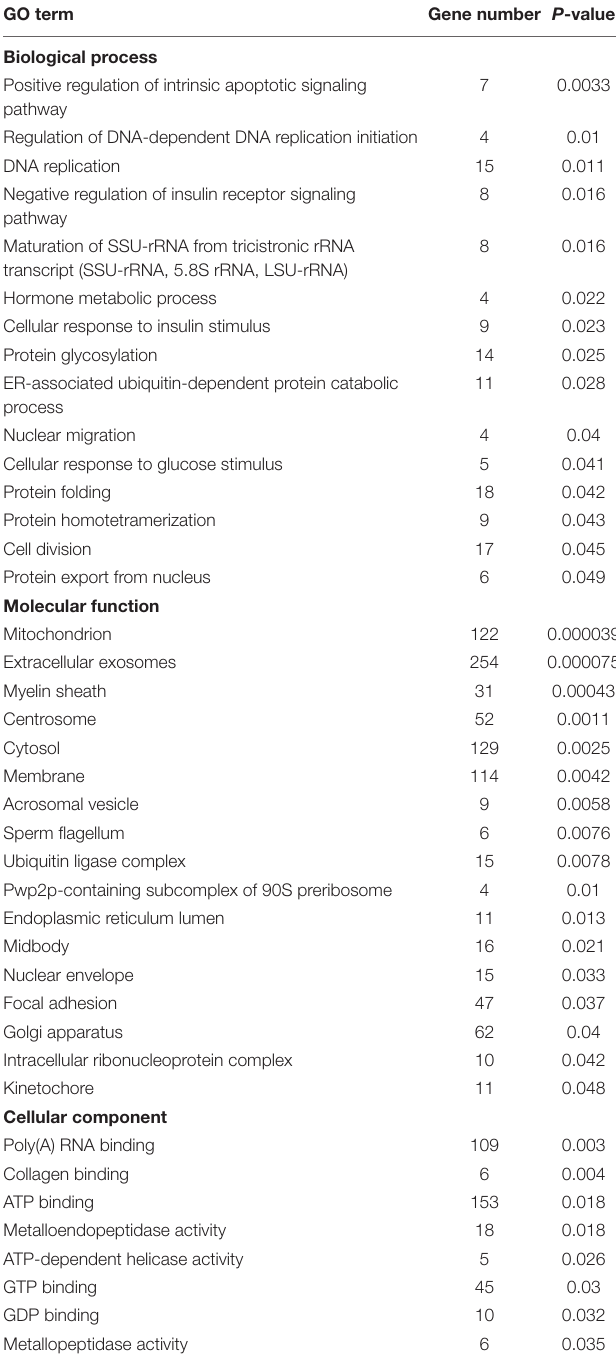
TABLE 2 | Gene ontology enrichment of differentially expressed genes.